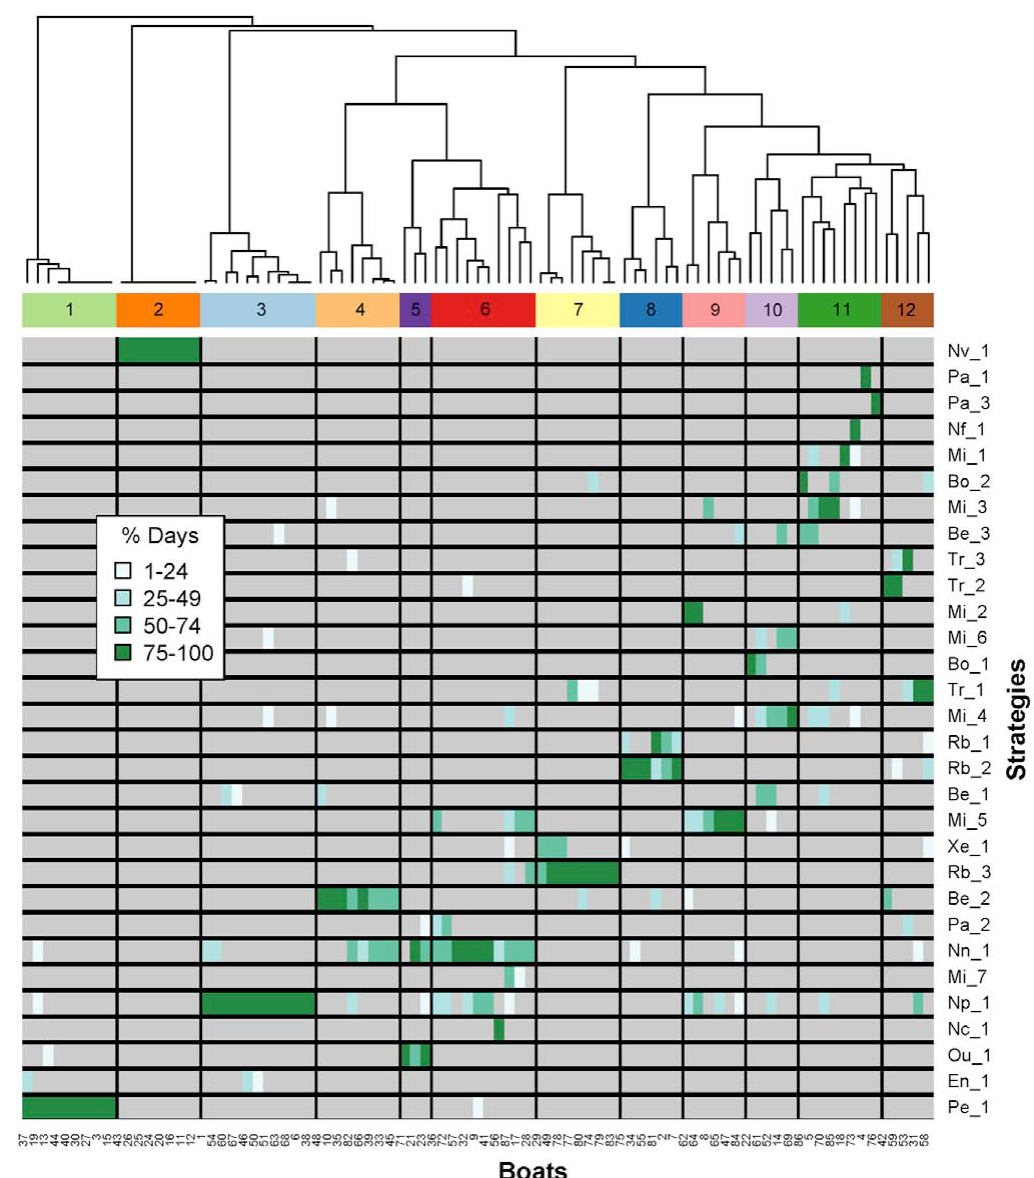
Fig. 4. – Heat map showing the combination of the fishing strategies most frequently combined by the interviewed boats (X-axis). The dendro- gram and colourbar on the top show the 12 types of fleet identified by the cluster analysis according to their annual fishing pattern. The green colour gradient shows the importance of the different fishing strategies for each boat in terms of percentage of days using the fishing